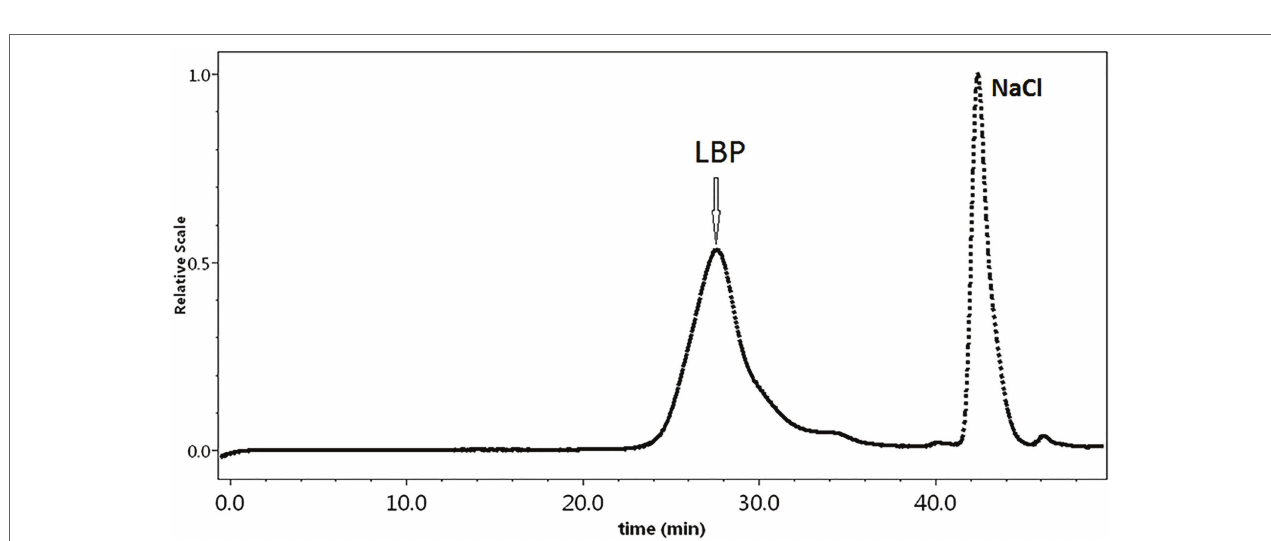
FIGURE 1 | The HPGPC chromatograms of Lycium barbarum polysaccharide (LBP)